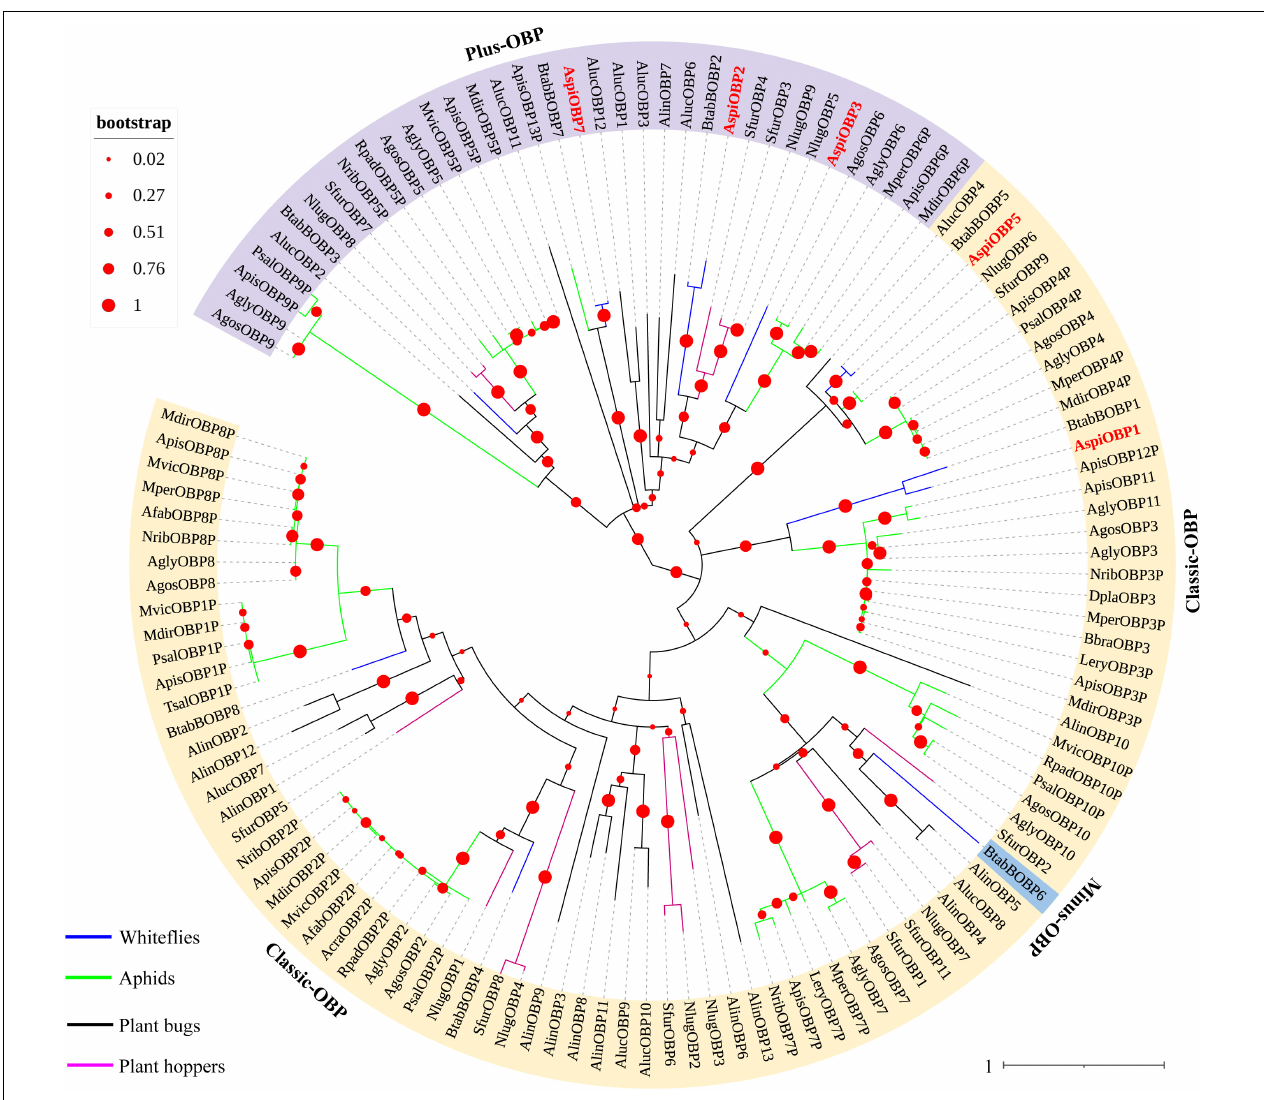
FIGURE 2 | Phylogenetic analysis of putative odorant-binding proteins (OBPs) of A. spiniferus . The phylogenetic tree was built using OBP sequences from whitefly species (Btab, Bemisia tabaci ; Aspi, A. spiniferus ), aphid species (Apis, Acyrthosiphon pisum ; Mper, Myzus persicae ; Agos, Aphis gossypii ; Psal, Pterocomma salicis ; Agly, Aphis glycines ; Mdir, Metopolophium dirhodum ; Mvic, Megoura viciae ; Bbra, Brevicoryne brassicae ; Lery, Lipaphis erysimi ; Afab, Aphis fabae ; Acra, Aphis craccivora ; Tsal, Tuberolachnus salignus ; Dpla, Drepanosiphum platanoidis ; Nrib, Nasonovia ribisnigri ; Rpad, Rhopalosiphum padi ), plant hoppers (Sfur, Sogatella furcifera ; Nlug, Nilaparvata lugens ), and plant bugs (Aluc, Apolygus lucorum ; Alin, Adelphocoris lineolatus